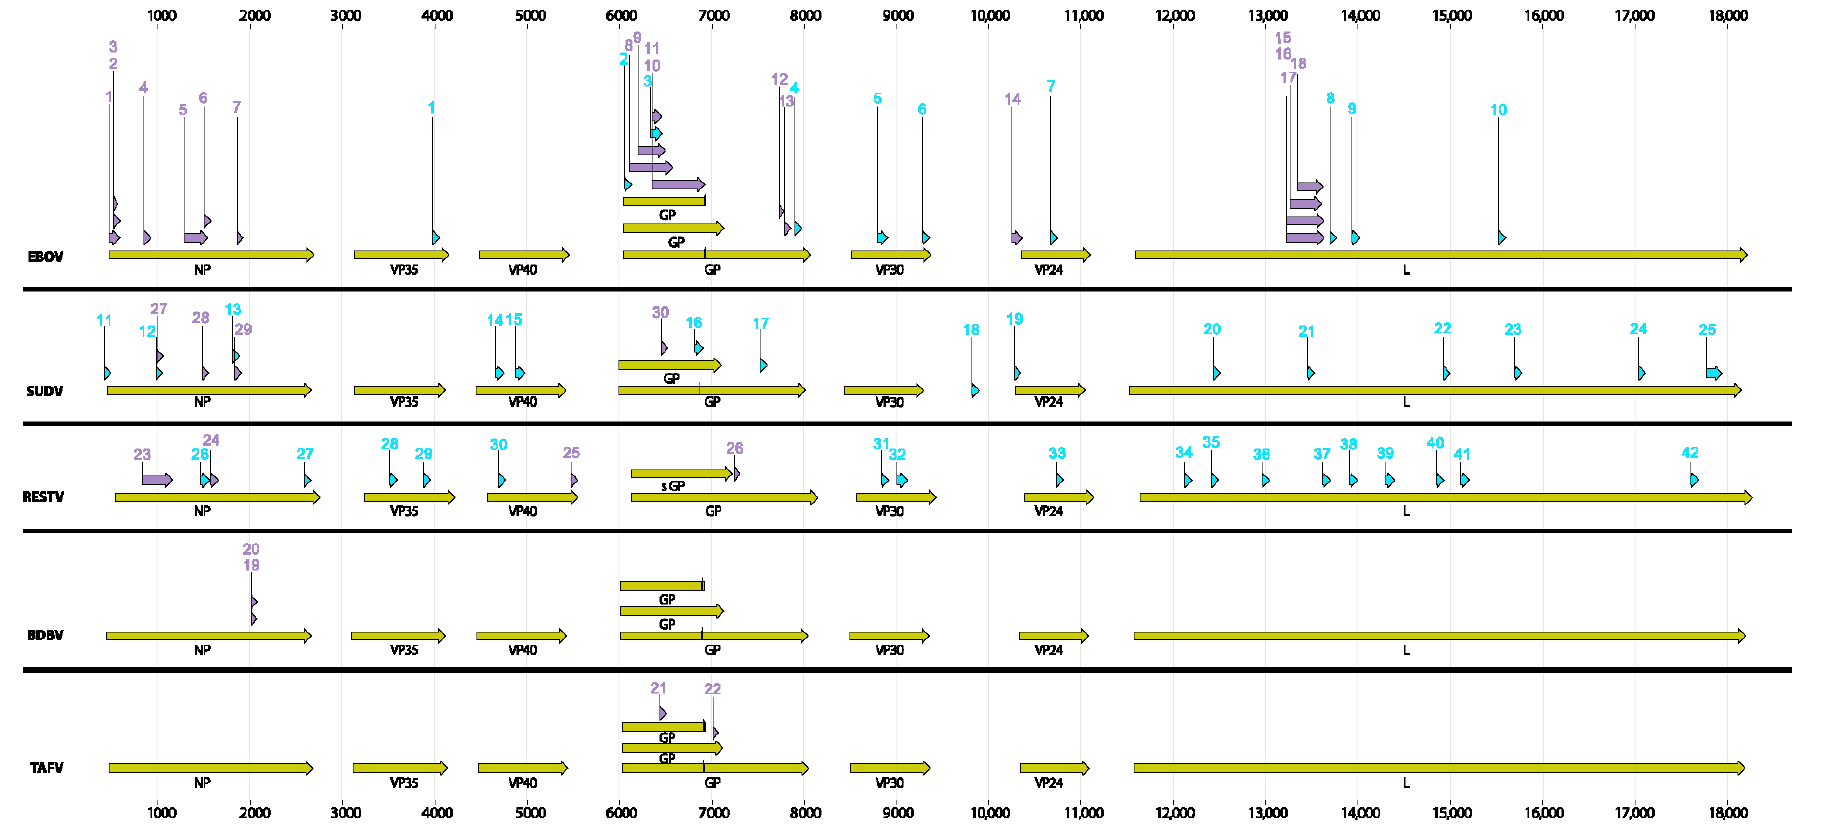
Figure 1. Genome maps of five members of the Ebolavirus genus (drawn to scale). The various genes (green arrows) and the location of the PCR amplicons of the current assays (purple arrows), and the Bio Velocity generated signatures (blue arrows) are marked. The numbers of the purple arrows correspond to the assay numbers described in Table S1 and those of the blue arrows correspond to sequences described in Table S4.